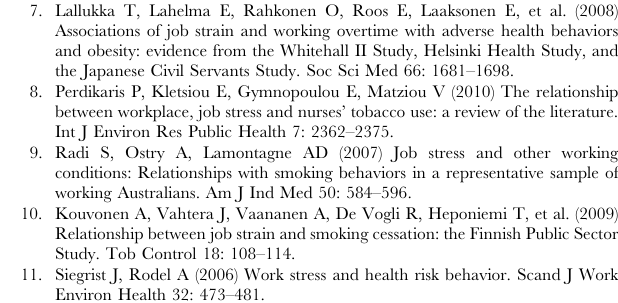
Figure S2 Associations of tobacco smoking and job strain (adjusted for age, sex and socioeconomic posi- tion). Figure S3 Associations of smoking and job strain, stratified by the availability of individual-level data (adjusted for age, sex and socioeconomic position). Table S1 Associations of smoking and work stress in demographic subgroups 1 . Table S2 Longitudinal associations between job strain and taking up smoking among baseline never- and ex- smokers. Table S3 Longitudinal associations between smoking at baseline and job strain at follow-up, stratified by baseline job strain category 1